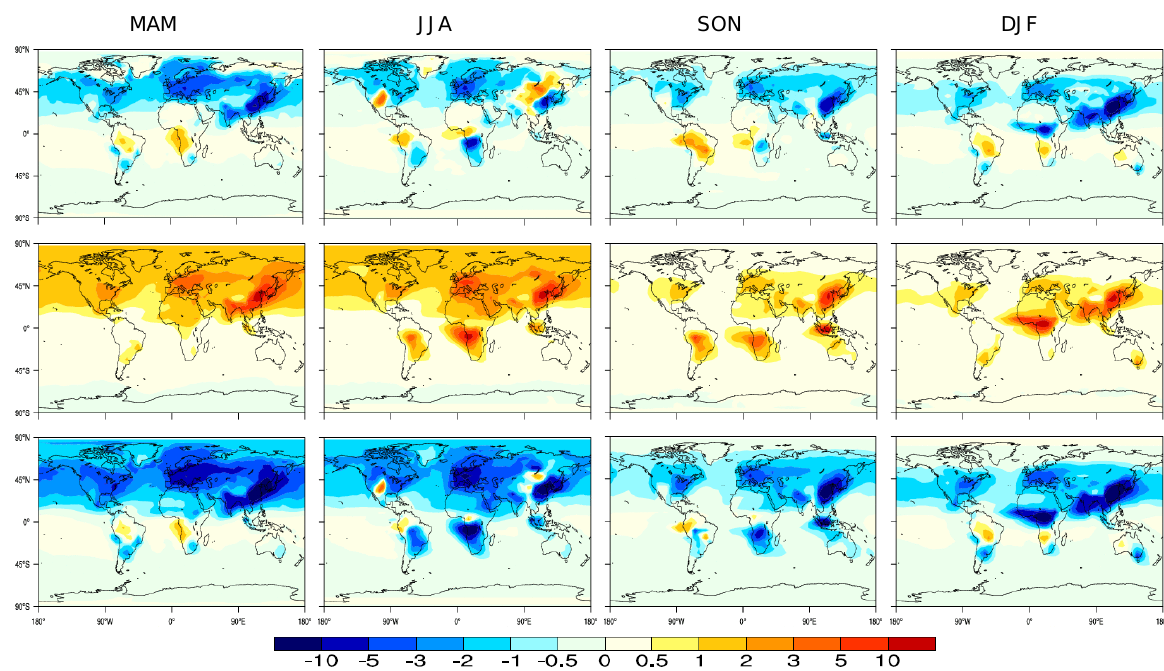
Fig. 9. Annual mean anthropogenic aerosol DRF at TOA (top), atmosphere (middle) and surface (bottom) for all sky in MAM, JJA, SON and DJF. Unit: Wm − 2 .